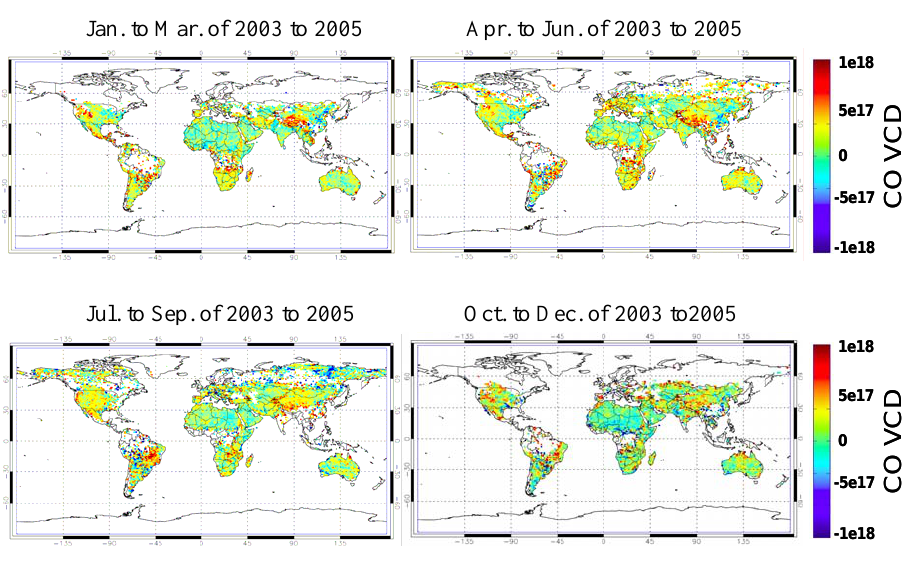
Fig. 12. Spatial distribution of averaged seasonal differences between SCIAMACHY and MOPITT CO columns with the same spatial-temporal sampling. White areas indicate missing values. It should be noted that over almost all regions the deviations are not significant according to the SCIAMACHY measurement uncertainties.